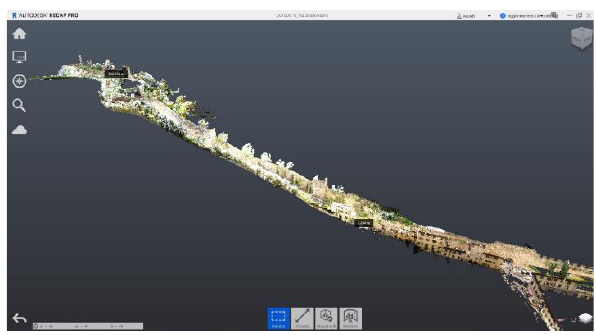
Figure 4. From Porta San Giorgio to Porta San Miniato.